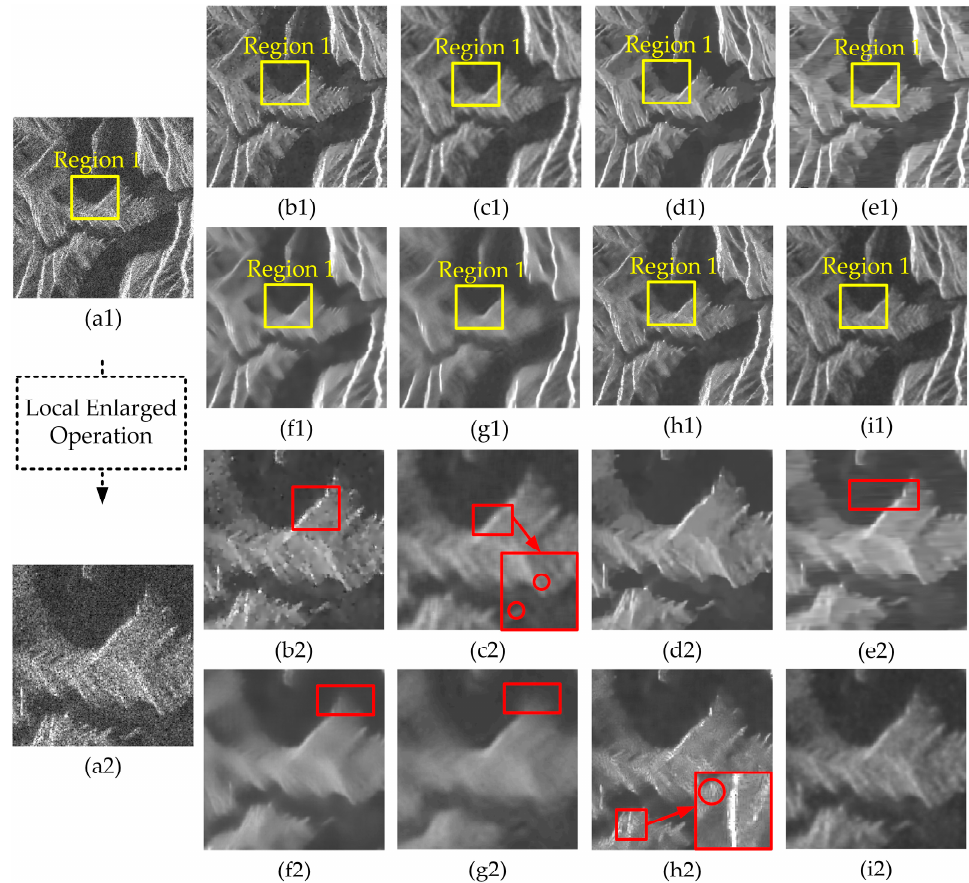
Figure 14. ( a1 ) ALOS-2 original image. Images filtered by ( b1 ) DPAD, ( c1 ) EnLee, ( d1 ) SAR-BM3-D, ( e1 ) FANS, ( f1 ) PPB, ( g1 ) DnCNN, ( h1 ) NL-means, and ( i1 ) MDLPIA-NLM filters. ( a2 – i2 ) Locally enlarged images of region 1 of ( a1 – i1 ), respectively. The red box and circle are areas for further observation.